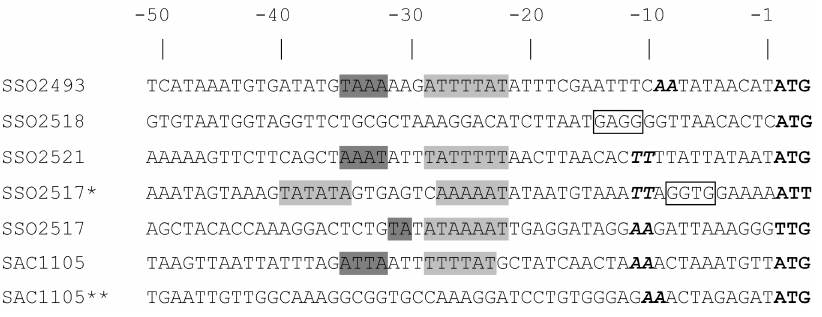
Figure 4. Sequences comparison of 50 nu- cleotides upstream of the start codon (bold) for putative esterases/lipases of S . solfataricus (SSO2493, SSO2517, SSO2518, SSO2521), S . acidocaldarius SAC1105, for the putative long version of SSO2517 (indicated with an asterisk) and for a short version of SAC1105 (indicated with a double asterisk). The putative translational signals were highlighted as follows: BRE motif, shadowed dark gray; Box A motif, shadowed gray; Shine-Dalgarno sequence, boxed; A/T peak centered at –10, italicized and bold; start codon, bold. A single asterisk (*) de- notes SsoN Δ long, and the double asterisk (**) denotes the short version of the puta- tive esterase from SAC1105.